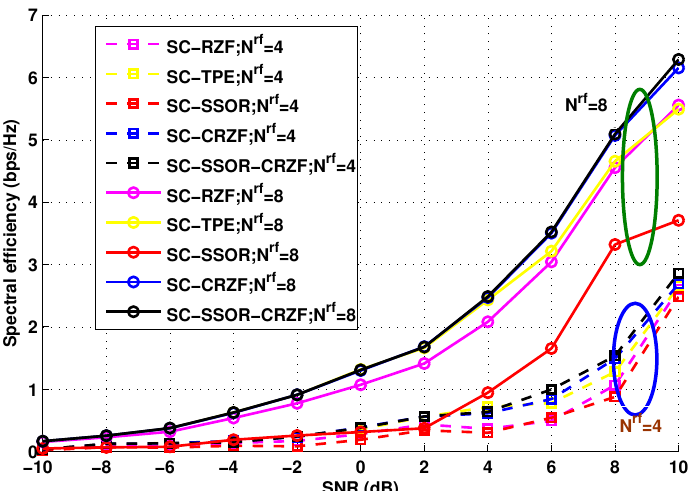
Figure 3. Spectral Efficiency Variation with N rf .